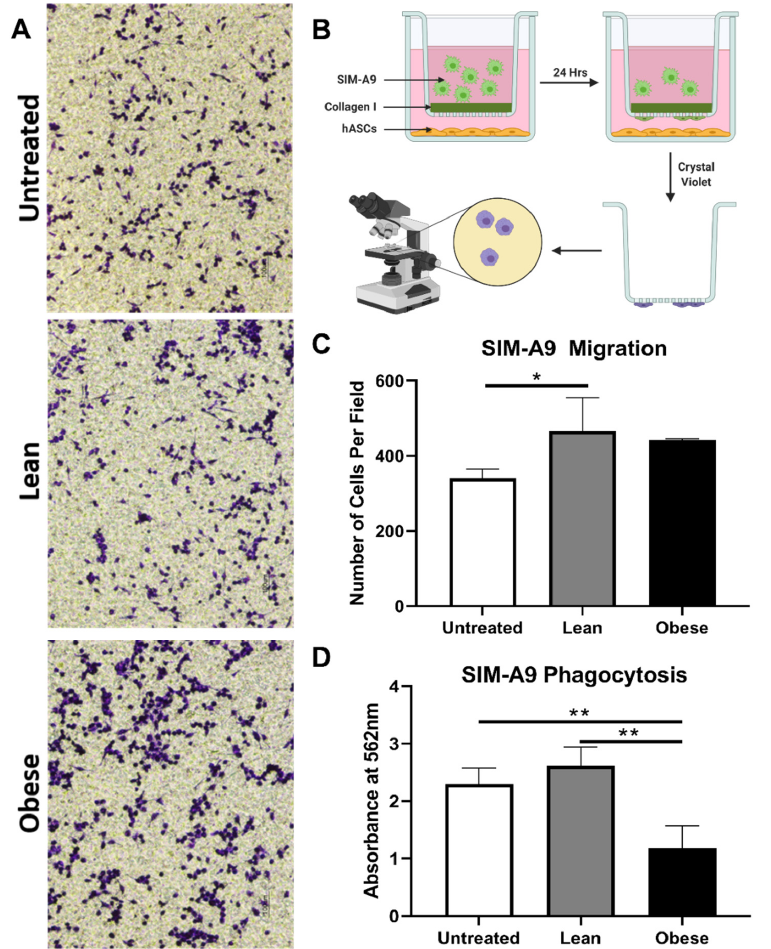
Figure 5. LnASCs and ObASCs differentially alter the migration and phagocytic abilities of SIM-A9 cells. ( A ) Representative images of crystal violet stained SIM-A9 cells following migration through a collagen-coated Transwell in the presence of LnASCs or ObASCs. ( B ) Representative scheme of migration assay process including staining and imaging. Created with Biorender.com ( C ) Quantification of the cells migrated per field based on three randomly chosen fields for each Transwell migration performed. ( D ) Phagocytosis of E. coli -substrate by SIM-A9 cells following 48-h treatment with LnASC or ObASC conditioned media. Values are presented as means (N = 3) of three independent experiments ± SD using one-way ANOVA followed by Dunnett’s multiple comparison test. Statistical differences between the means are marked with * p < 0.05, ** p < 0.01.